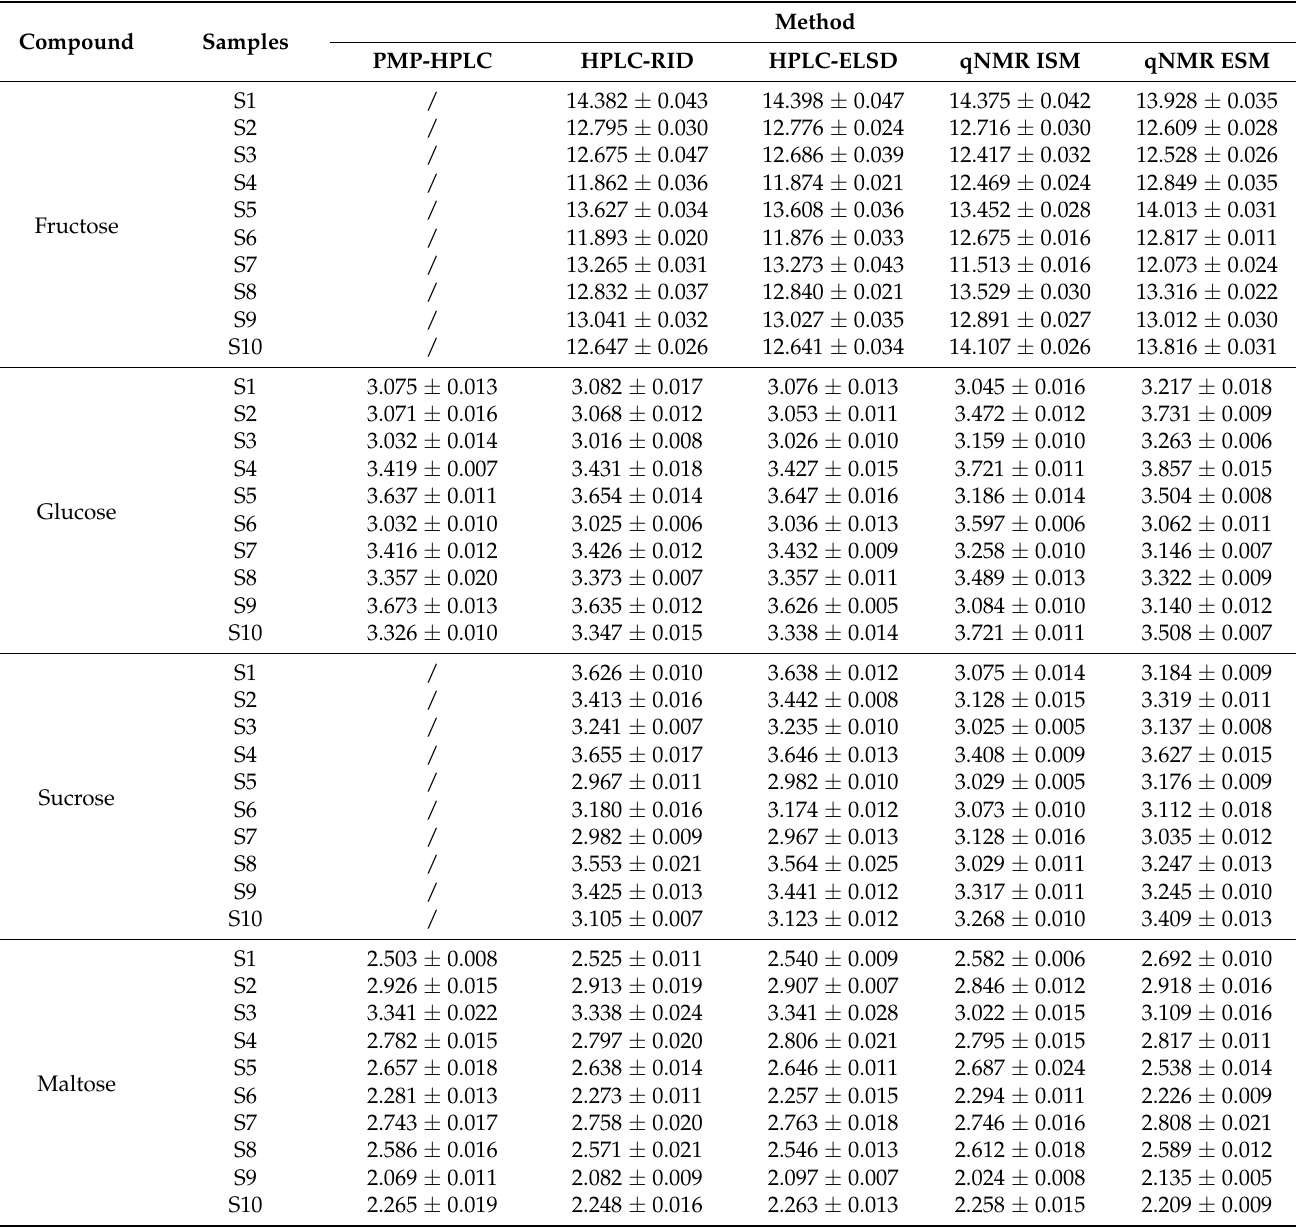
Table 6. Results of HPLC and qNMR determination of sugar content (%) in YQFM samples (mean ± RSD, n = 3).